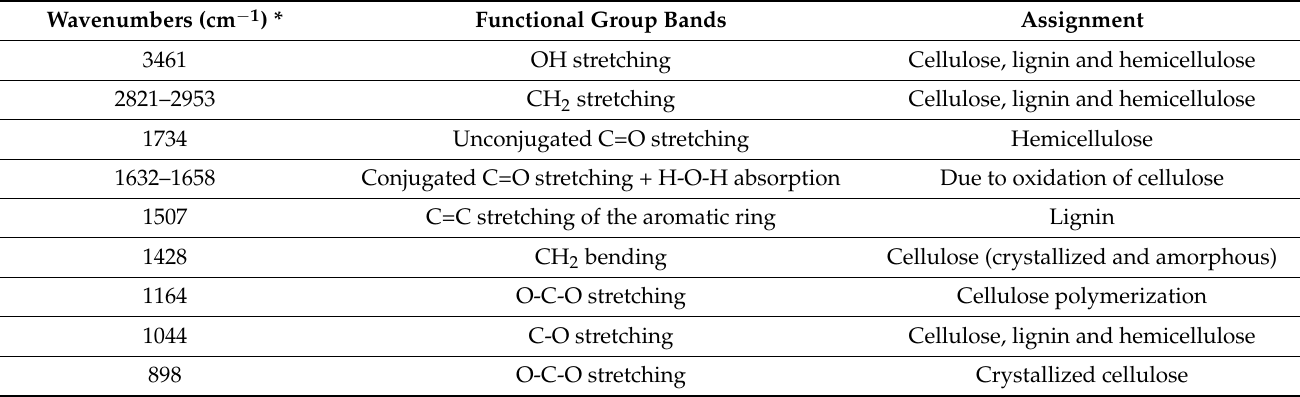
Table 4. Basic functional groups and their wavenumbers in natural